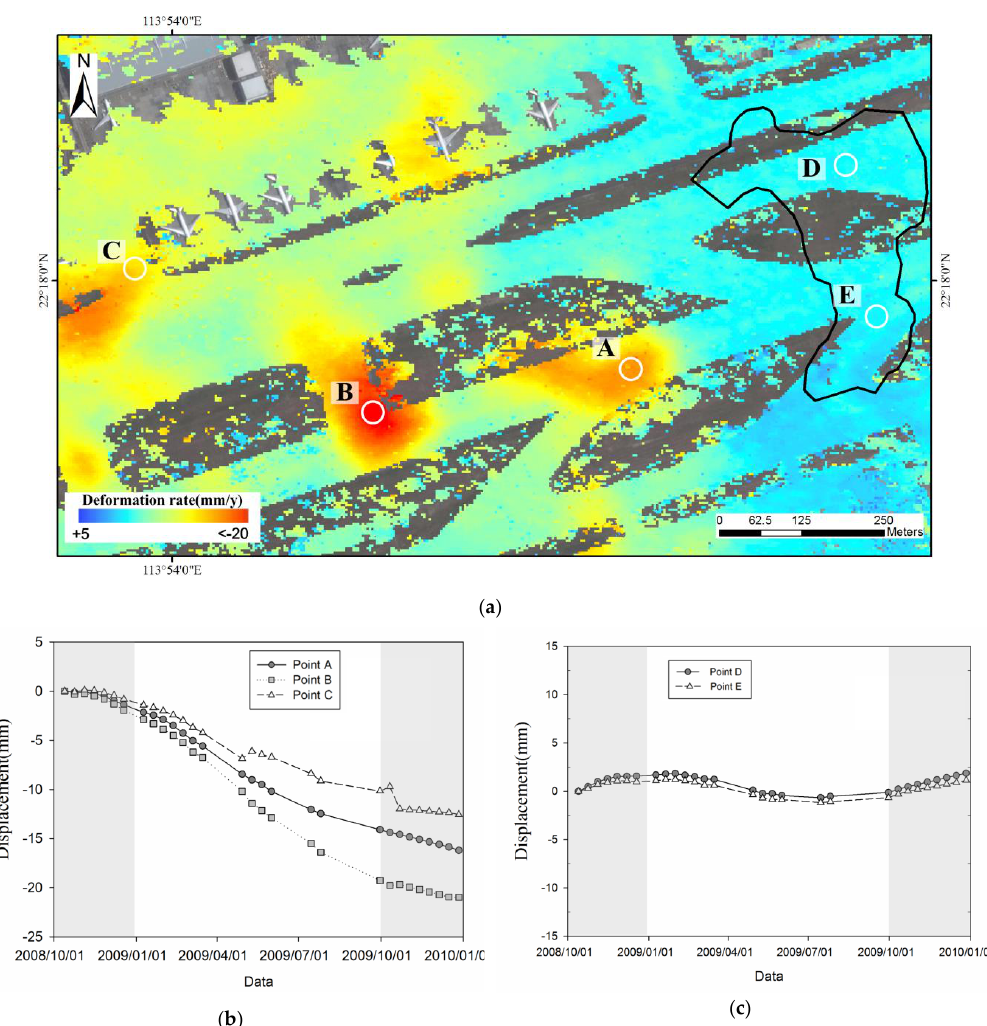
Figure 8. DSI results of the southern runway from TerraSAR-X Spotlight images, west of the original Lam Chau Island, the location of which is represented by the white rectangle (zone 2) in Figure 6b. ( a ) Linear deformation rate superimposed on Google Earth image, ( b ) displacement time series of points A, B and C, and ( c ) displacement time series of point D and E in Figure 8a. Grey areas approximately indicate the winter periods from Oct. to Dec. of 2008 and 2009.